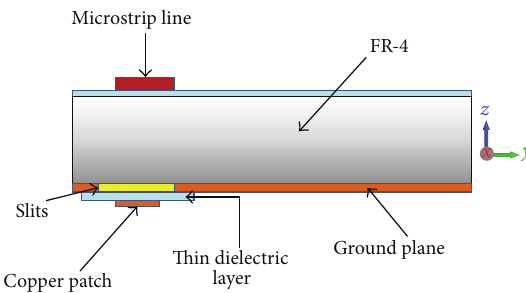
Figure 1: Schematic view of double-layered structure with microstrip line.